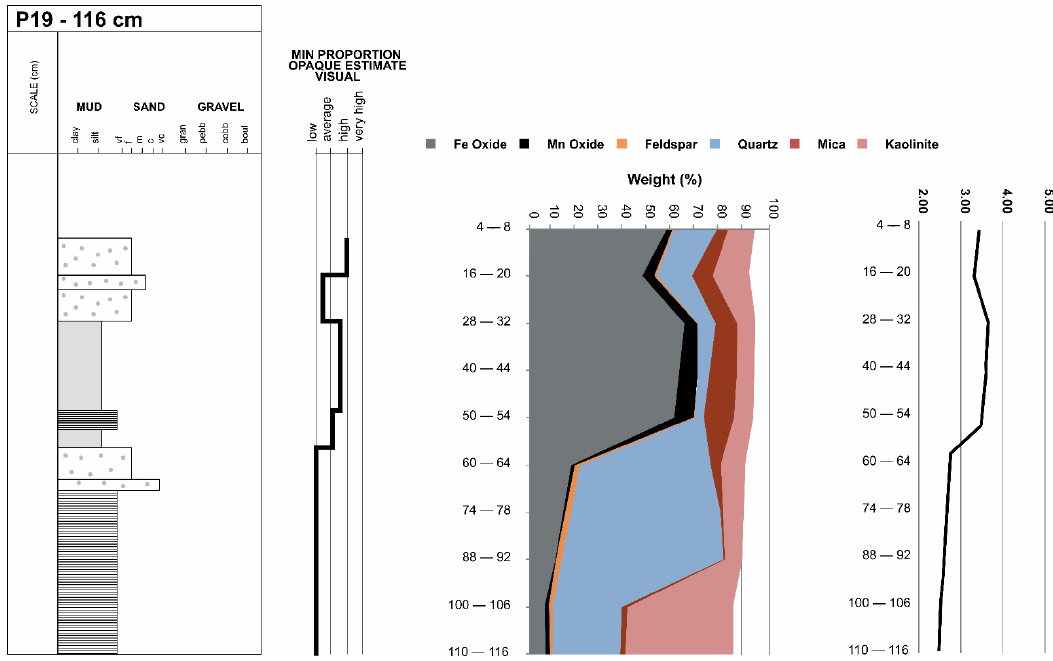
Figure 9. Multiproxy display of results obtained from P19 samples. From left to right one can observe the log with textural description, opaque relative proportions, modal mineralogy and density. Sampled intervals are indicated by the horizontal axis on the last two charts.